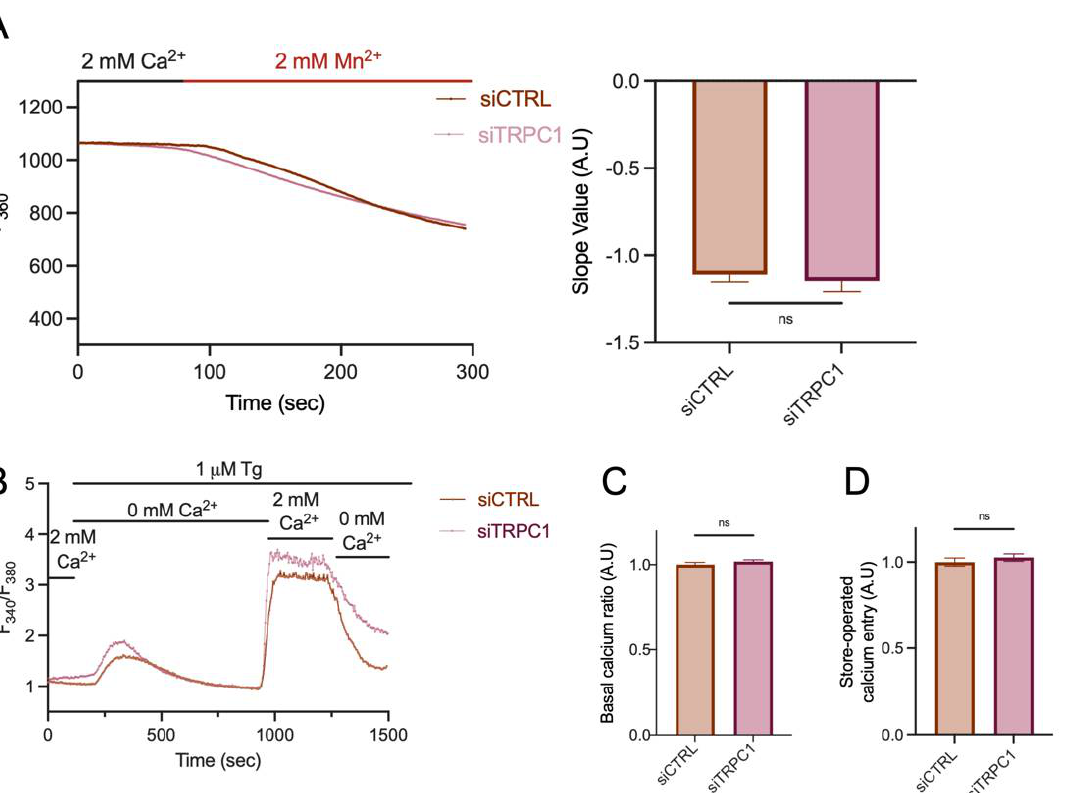
Figure 5. The knockdown of TRPC1 does not affect Ca 2+ entry and the proliferative role of PANC-1 cells does not depend on extracellular Ca 2+ concentration. ( A ) Representative traces of Mn 2+ quenching in PANC-1 cells (left panel) and the quantification of siCTRL and siTRPC1 transfected PANC-1 cells (right panel) (number of analyzed cells siCTRL = 342 and siTRPC n = 382). ns indicates non-significant. ( B ) Representative traces of the classical store-operated Ca 2+ entry protocol. Cells were perfused with 2 mM Ca 2+ for 1 min, then with 0 mM Ca 2+ and 1 µM thapsigargin (Tg) for 12 min, followed by 2 mM Ca 2+ for 5 min, and finally perfused with 0 mM Ca 2+ . ns indicates non- significant. ( C ) Quantification of basal Ca 2+ ratio (0 mM Ca 2+ ) in siCTRL and siTRPC1 transfected PANC-1 cells (number of analyzed cells siCTRL = 303 and siTRPC1 = 280). ns indicates non- significant. ( D ) Quantification of SOCE (2 mM Ca 2 after internal Ca 2+ -store depletion) in siCTRL and siTRPC1 transfected PANC-1 cells (number of analyzed cells siCTRL = 303 and siTRPC n = 280). ( E ) Trypan blue assay analysis of siCTRL and siTRPC1 transfected PANC-1 cells (for 72 h) either treated with medium containing extracellular Ca 2+ concentrations (+Ca 2+ ), or with medium depleted for extracellular Ca 2+ (−Ca 2+ ), for 48 h ( n = 3). Welch’s correction t-test and Tukey’s multiple comparison test ( E ) were used to determine significant difference between siCTRL and siTRPC1 conditions. **, and **** indicate p < 0.01, and 0.0001, respectively .